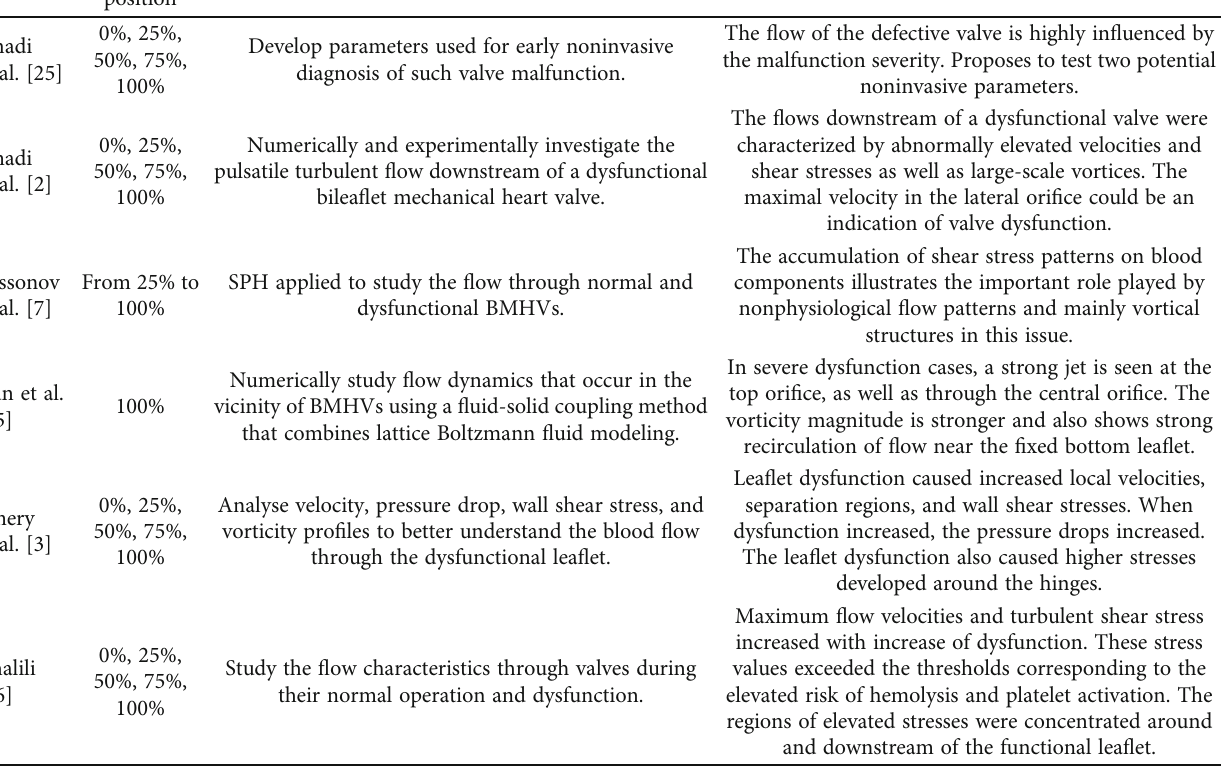
Table 2: MHV dysfunction simulation objectives and results.